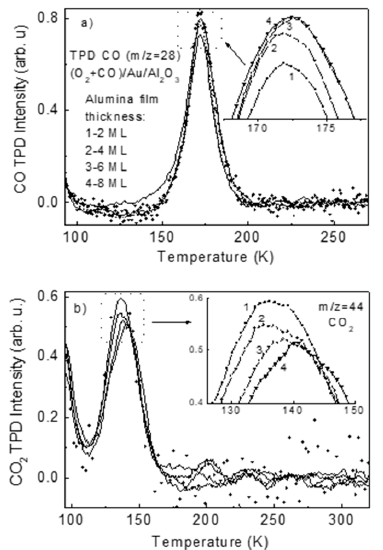
Figure 4. TPD spectra of CO ( a ) and CO 2 ( b ), acquired during continuous exposure of CO/Au/Al 2 O 3 to oxygen via backfilling the UHV chamber by O 2 to a partial pressure of 10 − 6 mbar. Inlays depict the TPD peak maxima area. Alumina film thickness: (1)—2 mL; (2)—4 mL; (3)—6 mL; (4)—8 mL.